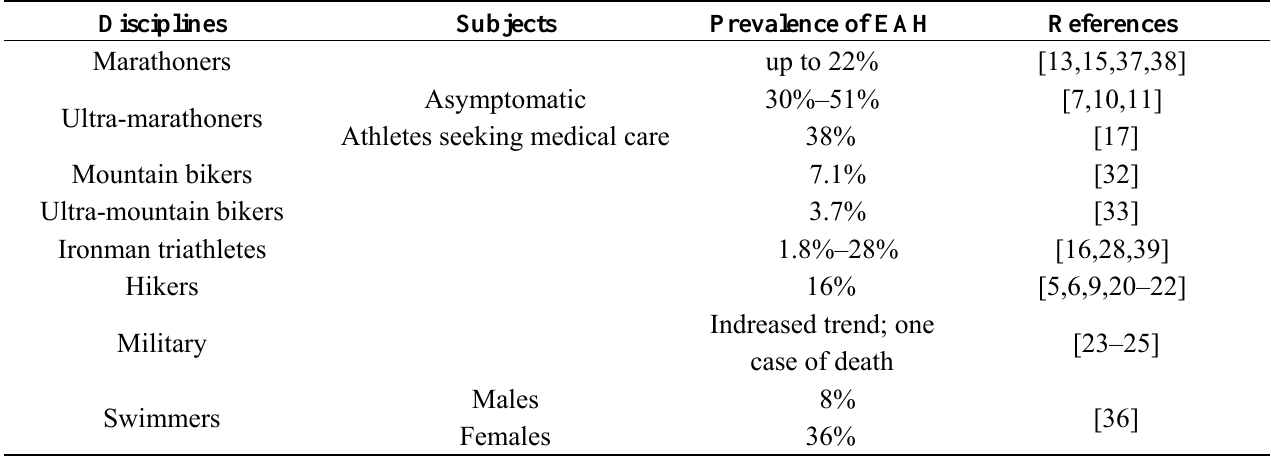
Table 1. Prevalence of exercise-associated hyponatremia (EAH).